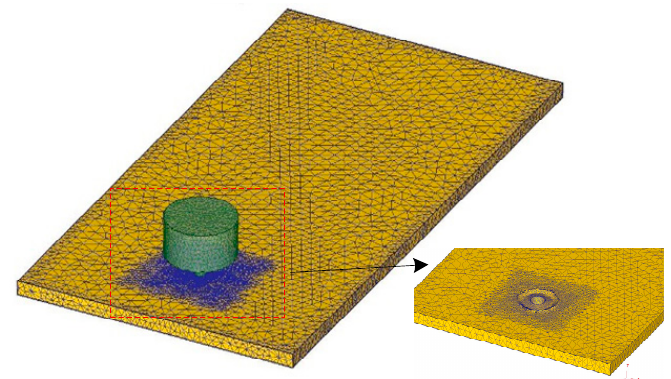
Figure 3. Geometric model in finite element model (FEM) simulation.